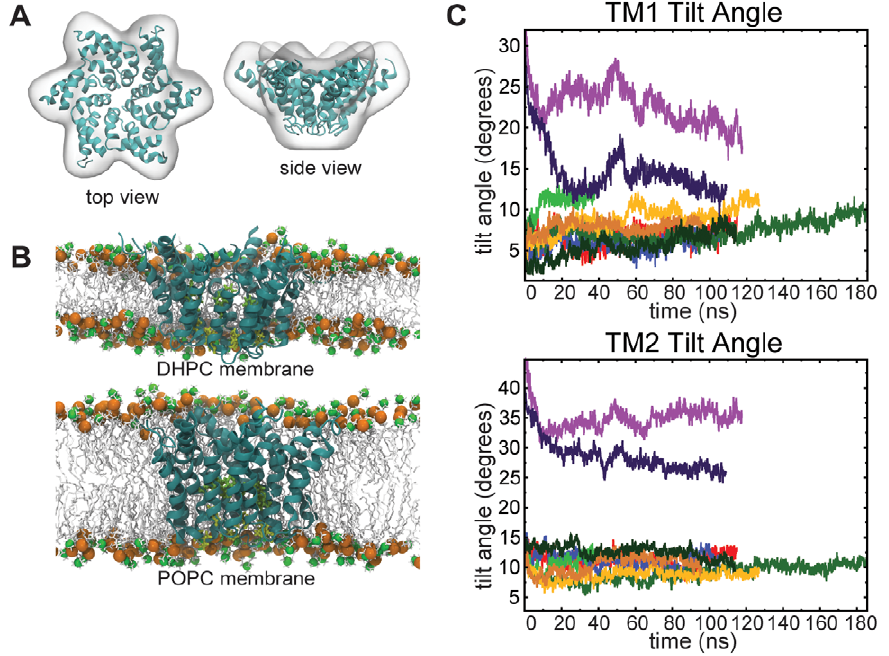
Figure 4. Conformation of the p7 hexamer in short– and long–tail lipid environments. (A) Hexamer B model (ribbon representation) fitted into the EM envelope of Luik et al [18]. (B) Side views of the EM-fitted hexamer model in the DHPC and the POPC lipid bilayers (for details and color code, see legend of Figure 3). (C) Tilt angles of TM1 and TM2 helices calculated for all models (for color code of oligomers, see legend of Figure 2). Relaxation of the model placed in POPC towards an upright conformation akin to that of Hexamer B is recognized through lower values of the TM1 and TM2 tilt angles.